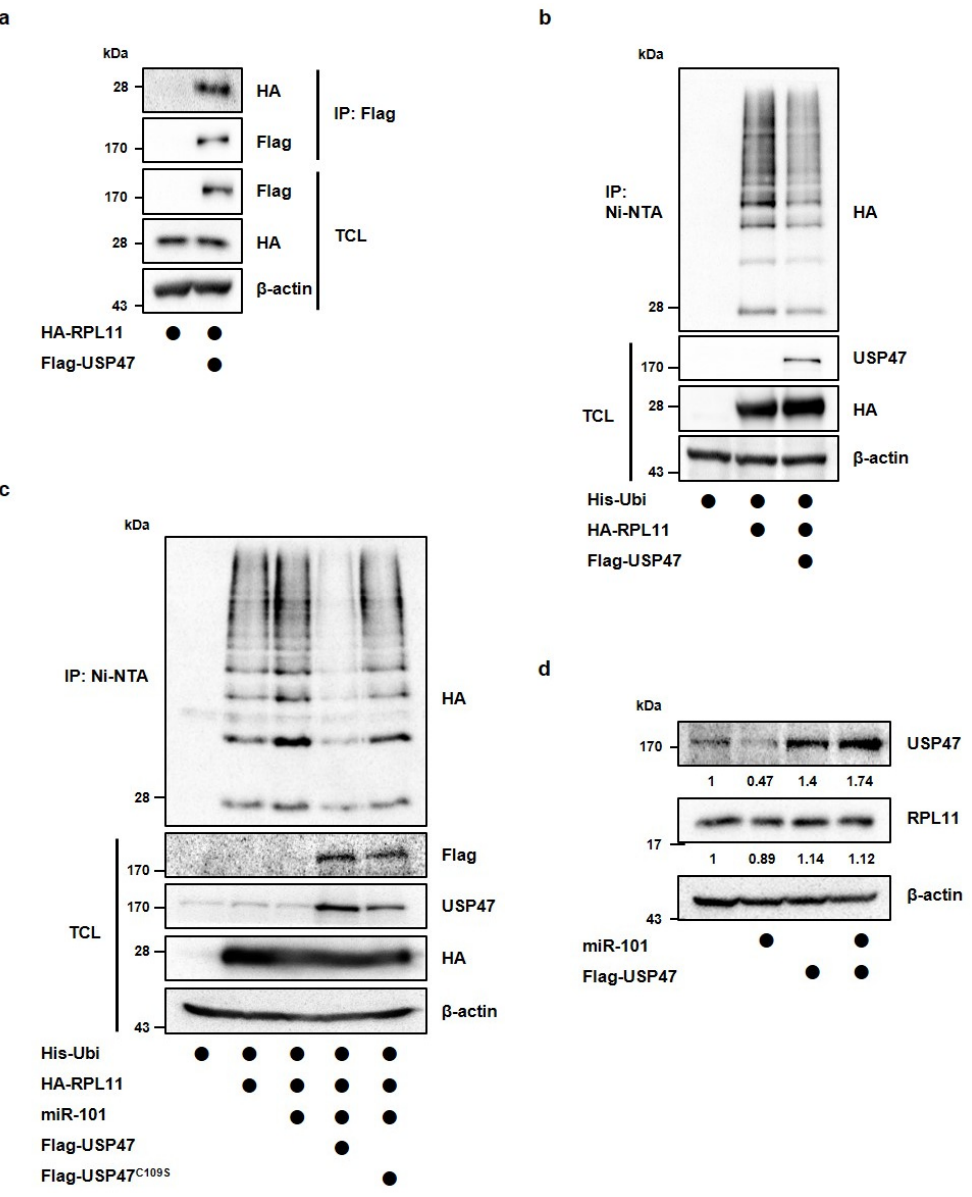
Figure 4. MiR-101-3p suppresses RPL11 deubiquitination by USP47. ( a ) HEK293T cells were transfected with HA-RPL11 alone or in combination with Flag-USP47. The interaction between Flag-USP47 and HA-RPL11 was detected by immunoblotting after immunoprecipitation with anti-Flag magnetic beads. ( b ) HEK293T cells were transfected with His-ubiquitin alone or together with HA-RPL11 and Flag-USP47, and then treated with proteasomal inhibitor MG132 (10 µ M) for 4 h. RPL11 ubiquitination was observed using a Ni-NTA pulldown assay. ( c ) HEK293T cells were transfected with His-ubiquitin alone or together with HA-RPL11, miR-101-3p mimic, Flag-USP47, or Flag-USP47C109S, and then treated with proteasomal inhibitor MG132 (10 µ M) for 4 h. RPL11 ubiquitination was observed using a Ni-NTA pulldown assay. ( d ) A594 cells were transfected with miR-101-3p mimic or Flag-USP47 alone, or together. Western blot analysis was performed to detect the USP47 and RPL11 protein levels. IP, immunoprecipitation; TCL, total cell